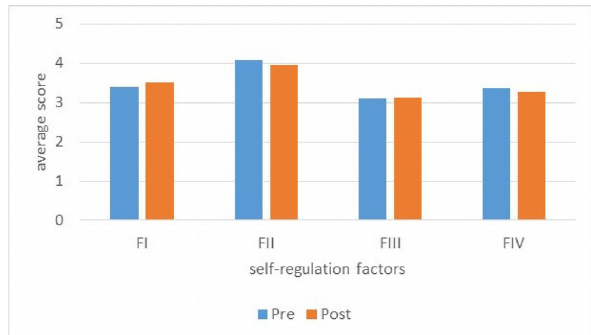
Figure 3. Average score of self-regulation factors (FI – active meta-cognitive awareness, FII - control and verification, FIII – daily effort in tasks, FIV – active processing in